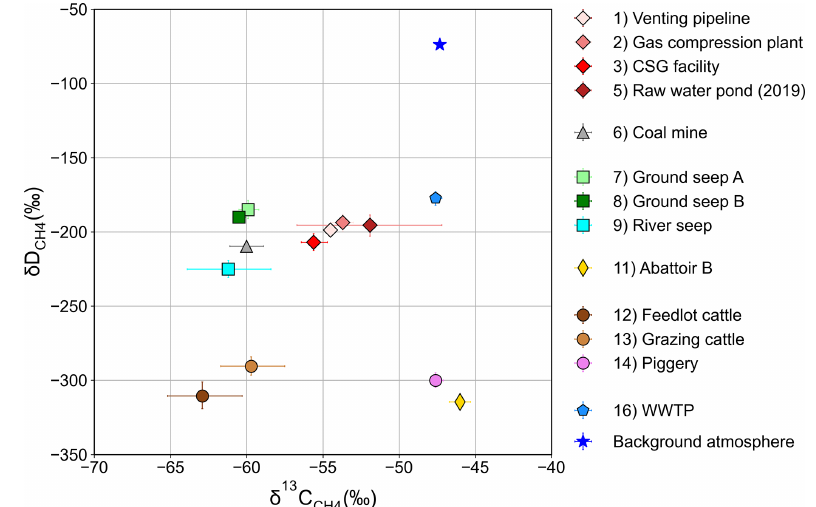
Figure 3. Dual isotope plot of all measured CH 4 sources in the study. For markers with missing error bars the Bayesian credible intervals were smaller than the symbol size. Please refer to Table 2 for detailed information of plotted